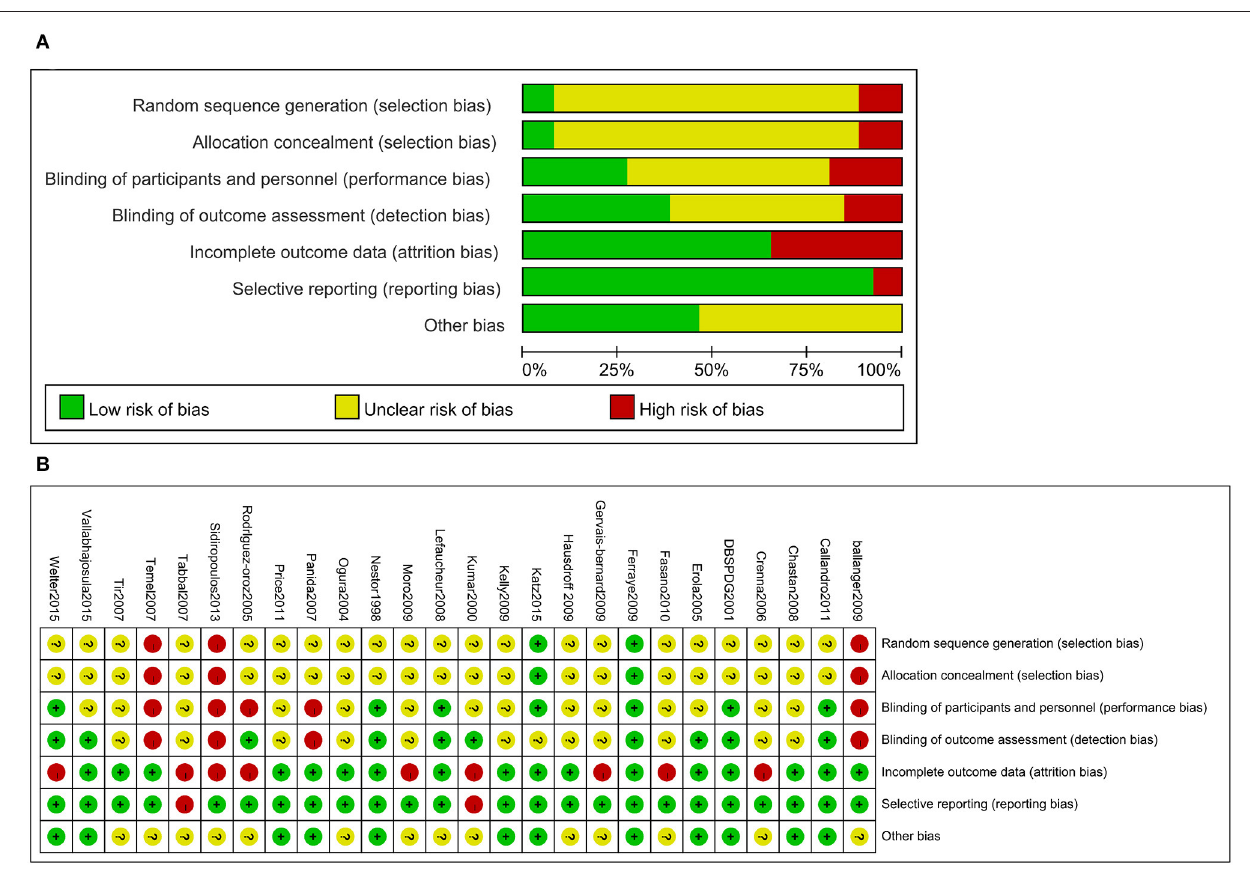
FIGURE 4 | Risk of bias for the included trials (A) . Risk of bias summary for the included trials (B)